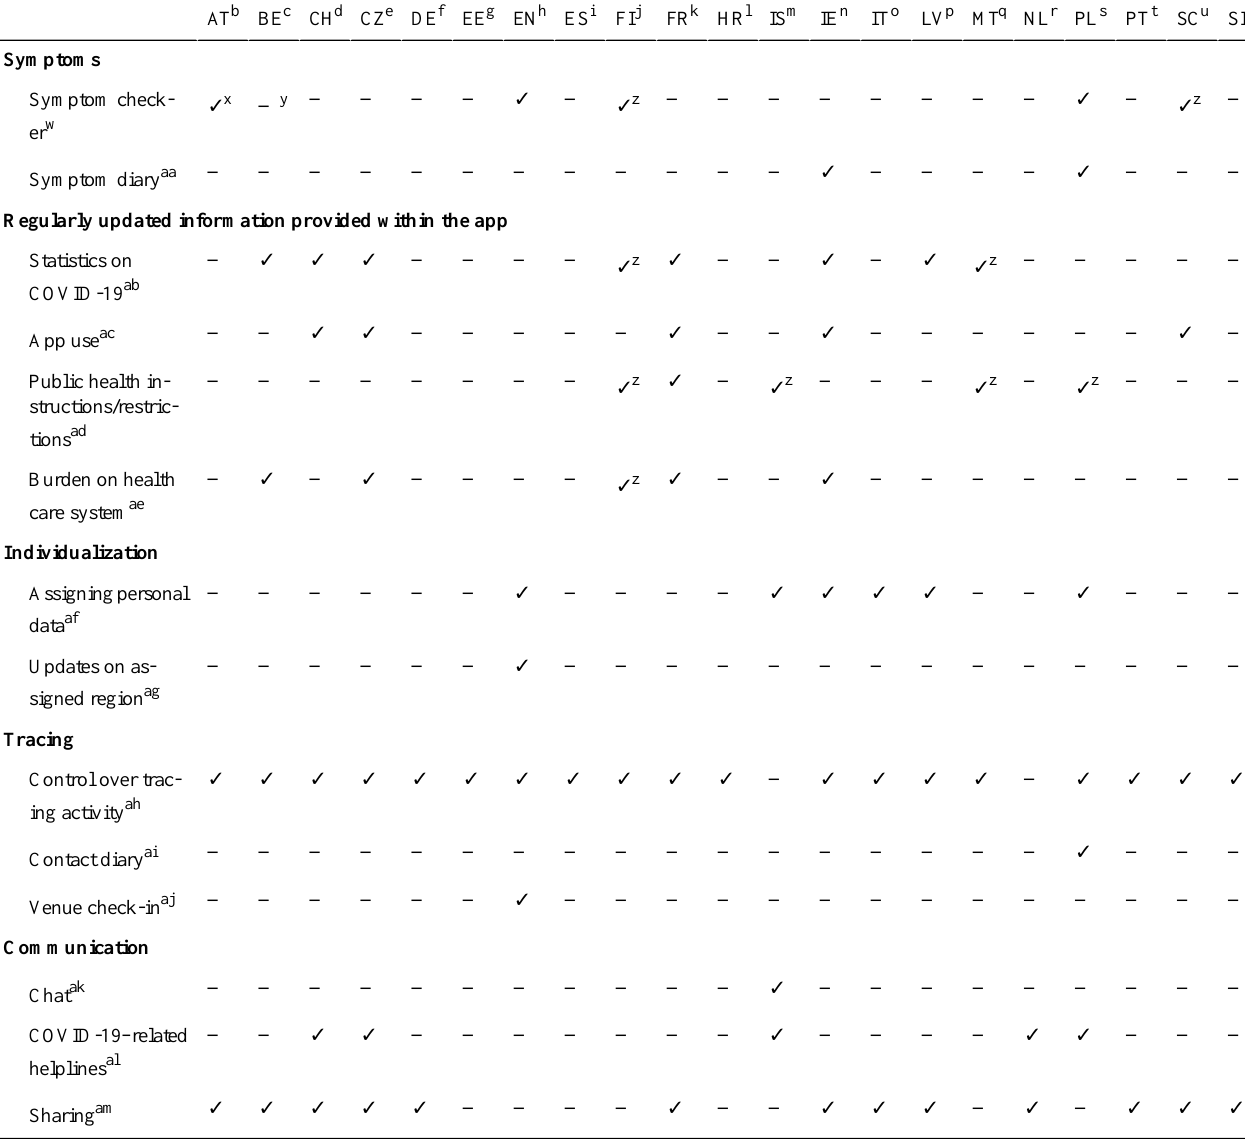
Table 3. Features of COVID-19 contact tracing apps contributing to engagement. CountriesCategories and